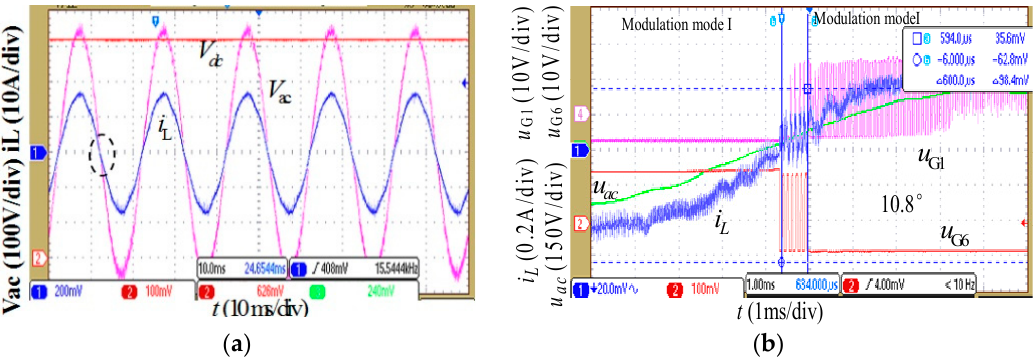
Figure 20. Voltage and inductor current under the HMM. ( a ) HMM: Voltage and inductor current, θ = 0°. ( b ) HMM: Zoom in during the zero-crossing area, θ = 0°.